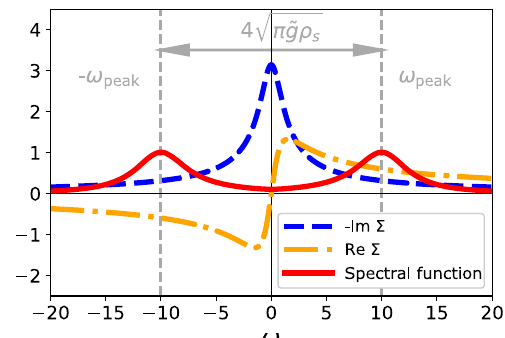
FIG. 18. Pseudogap regime: real (orange) and imaginary (blue) parts of the self-energy on the real axis phenomenologically calculated in weak-coupling spin-fluctuation theory and its corresponding spectral function